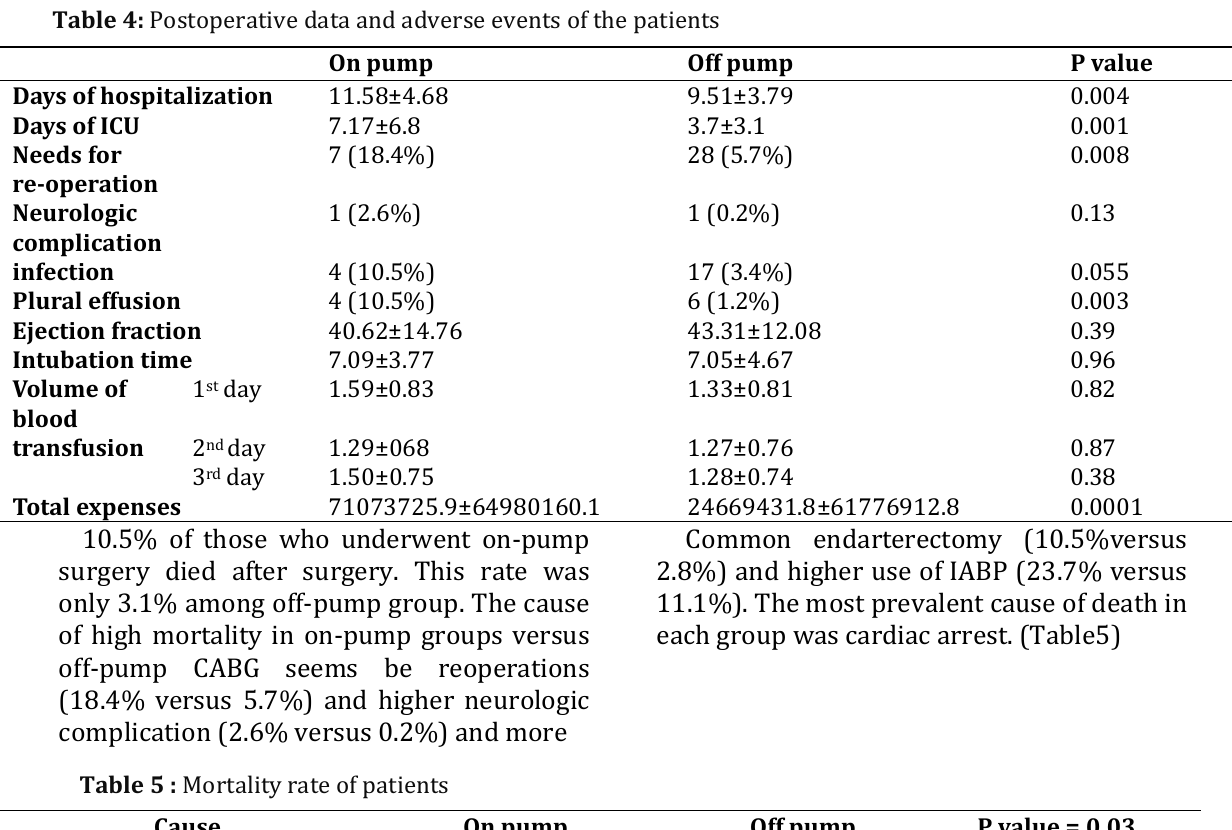
Table 4: Postoperative data and adverse events of the